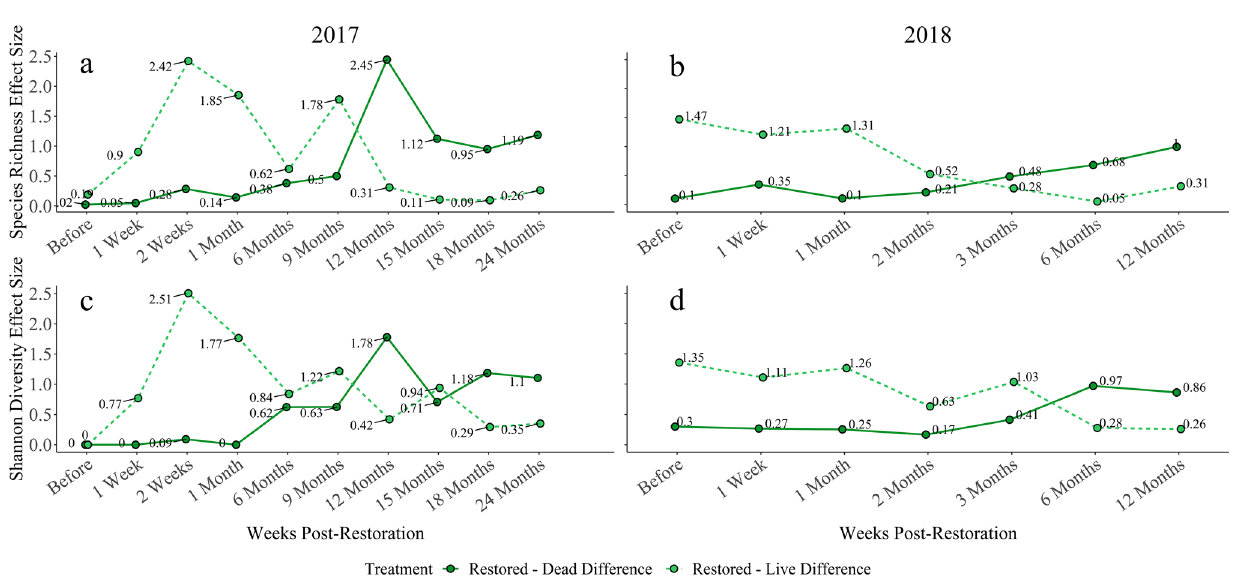
Figure 2. Effect sizes (Cohen’s D) of treatment on diversity metrics between restored and dead reefs as well as restored and live reefs over time. Species richness on 2017 reefs ( a ), Shannon diversity on 2017 reefs ( c ), species richness on 2018 reefs ( b ), and Shannon diversity on 2018 reefs ( d